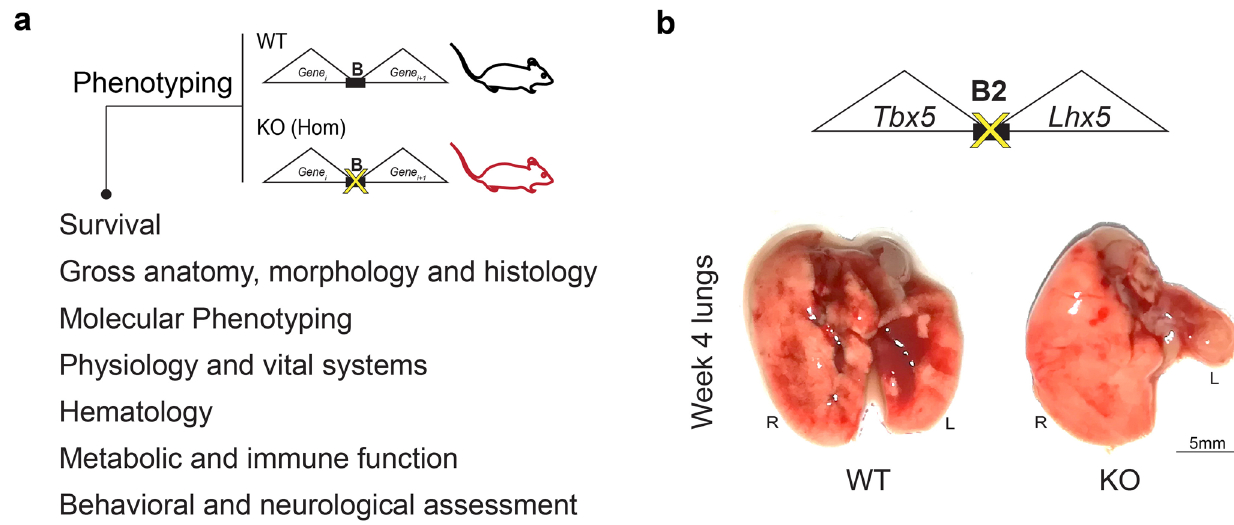
Fig. 4 TAD boundary deletions result in developmental phenotypes. a Overview of comprehensive phenotypic assessment performed to characterize effects of TAD boundary deletion in vivo. b Homozygous mutants (KO) for TAD boundary deletion locus B2 show vestigial left lung. Scale bar, 5